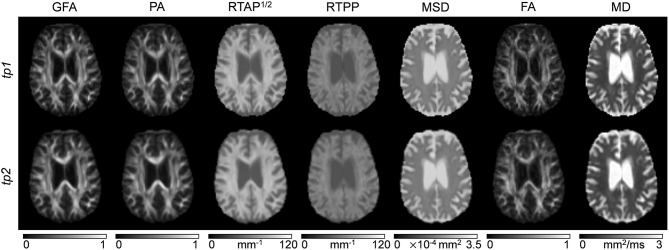
dMRI-based indices on a representative control. Axial slices of a representative control are reported for each index (columns) and each time point (rows). Images are displayed in radiological convention.